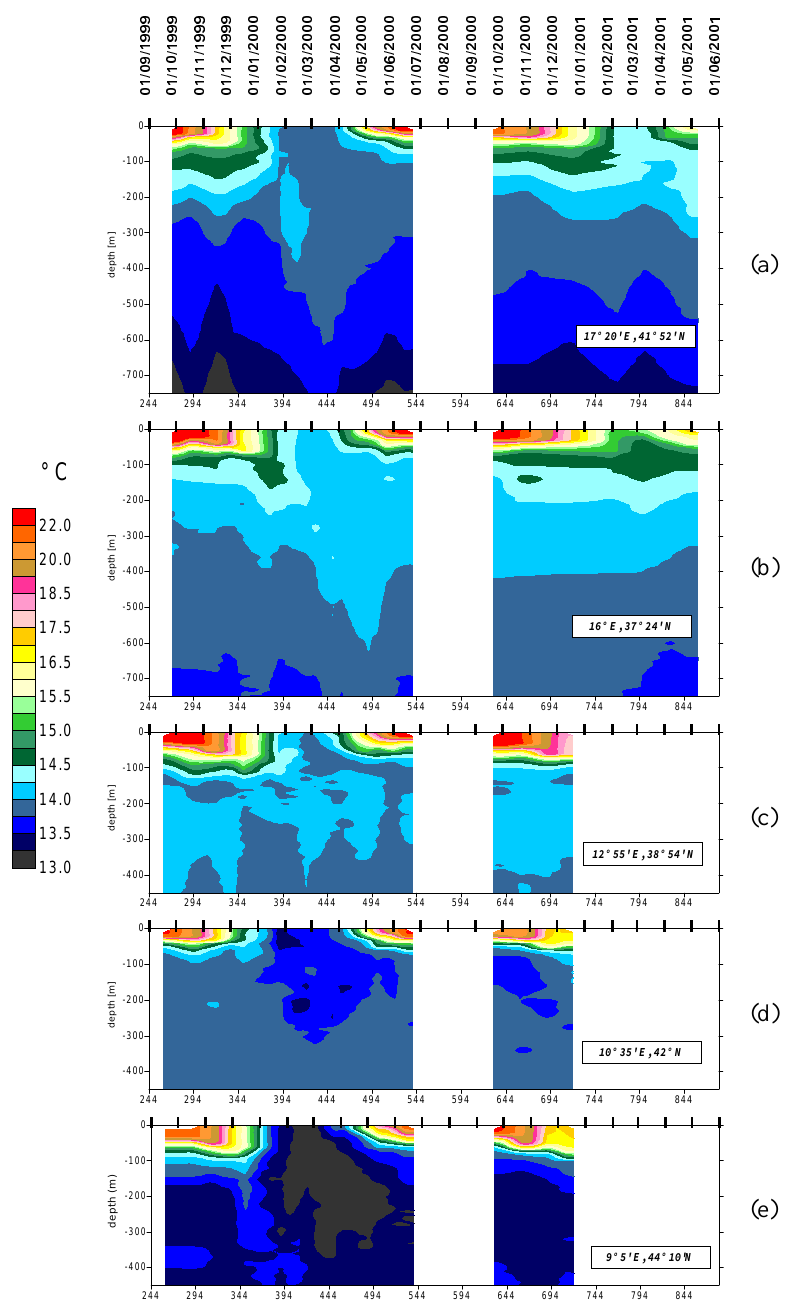
Fig. 3. Temporal evolution of ther- mal structures: in the southern Adriatic (a) , NW Ionian (b) , southern Tyrrhe- nian Sea (c) , northern Tyrrhenian (d) , and Ligurian Sea (e) . Approximate po- sition of the locations is indicated by geographical